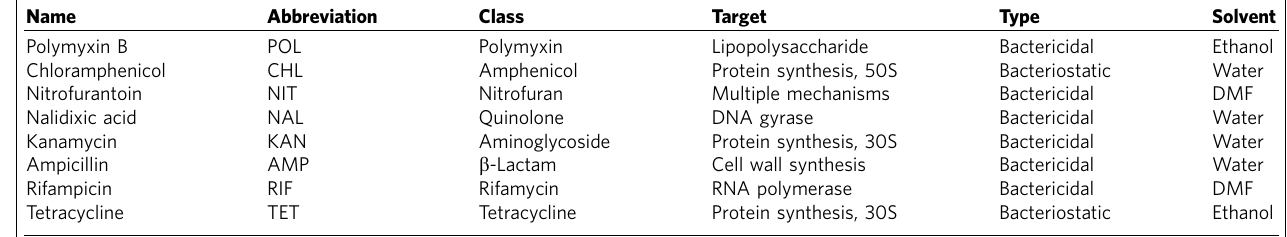
Table 1 | List of antibiotics used in this study.